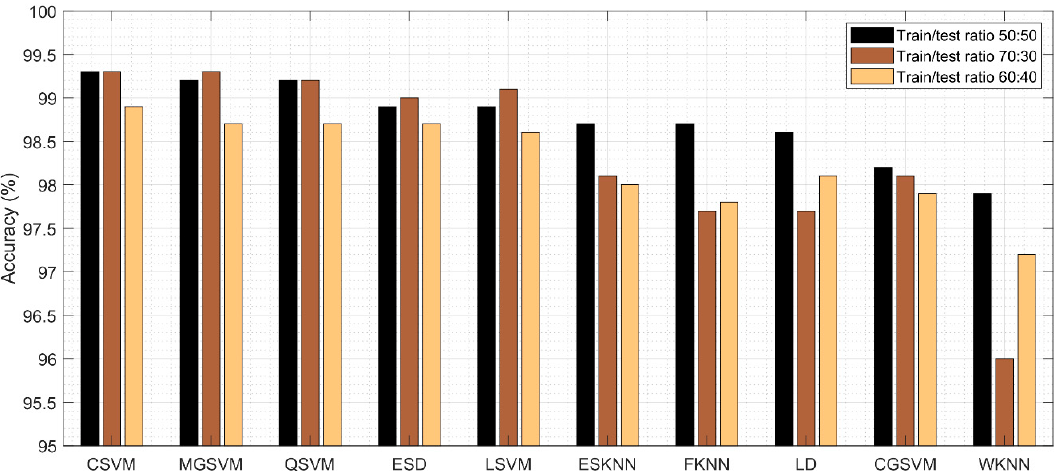
Figure 9. Summary of DarkNet53 classification accuracy using different training/testing ratios.